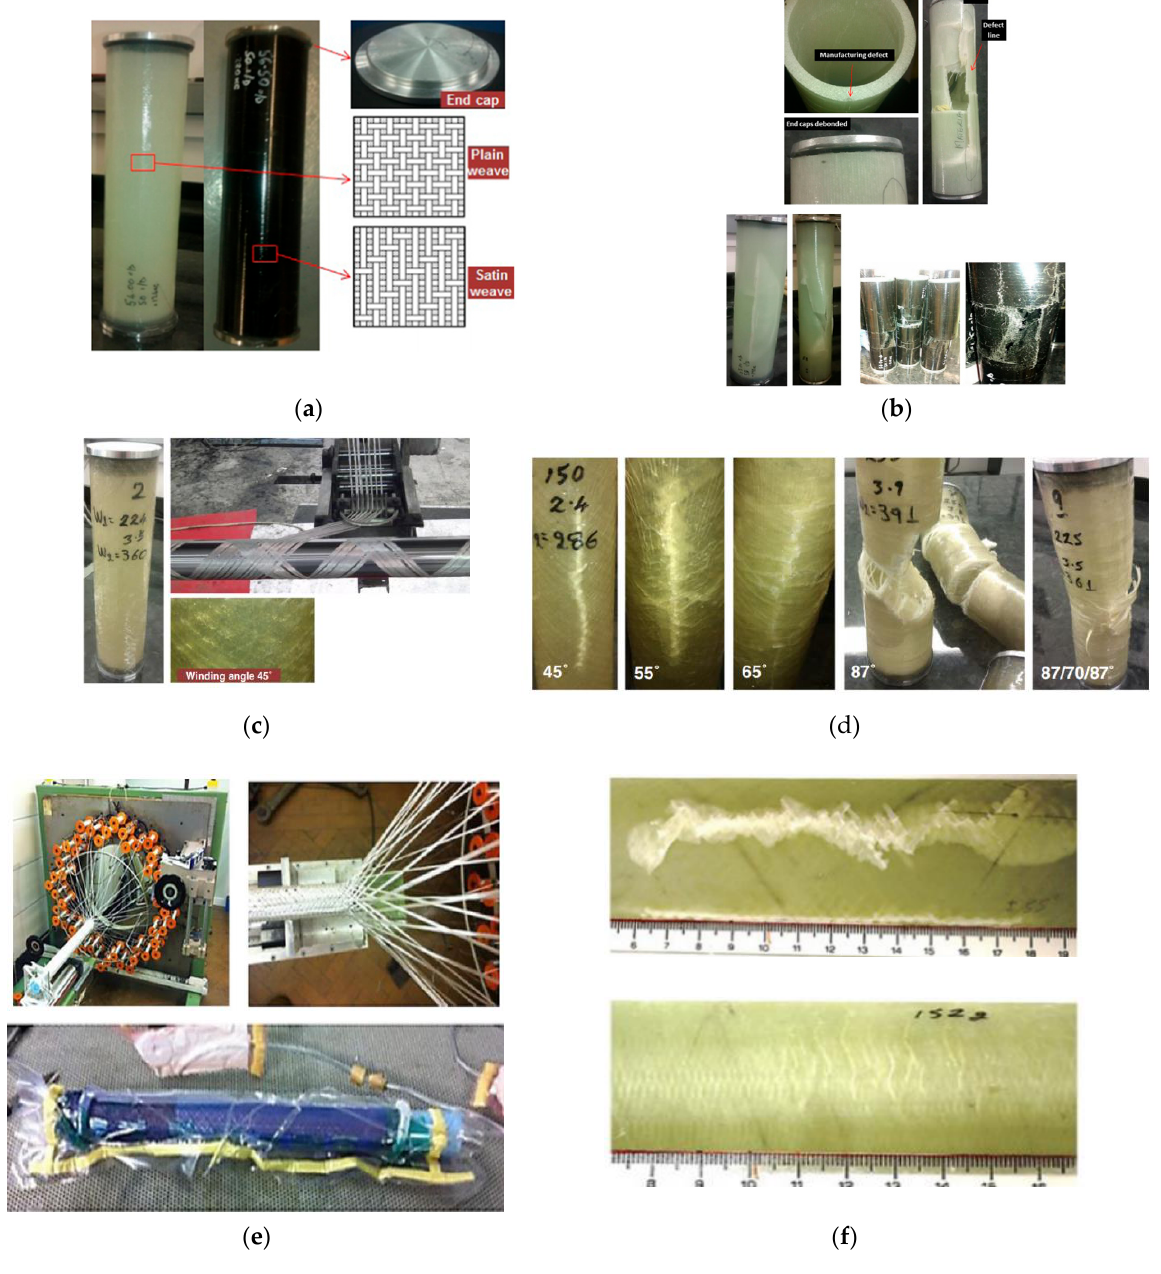
Figure 2. Composite tubes manufactured with different processes and typical failure modes under hydrostatic pressure [27]. ( a ) Composite tubes manufactured with Prepreg layup process; ( b ) Typical failure mode of prepreg laminate tubes under hydrostatic pressure; ( c ) Composite tubes manufactured with helical filament wound process; ( d ) Typical failure mode of composite tubes with different single filament wound angles under hydrostatic pressure; ( e ) Composite tubes manufactured with braiding process; ( f ) Typical failure mode of composite tubes with different braid angle under hydrostatic pressure.